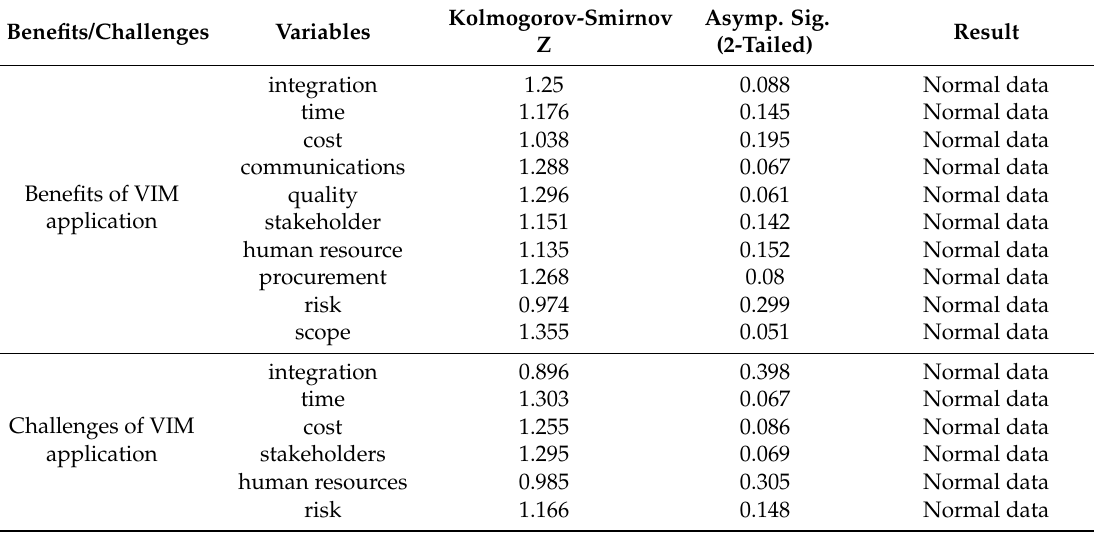
Table 5. Results of the Kolmogorov–Smirnov